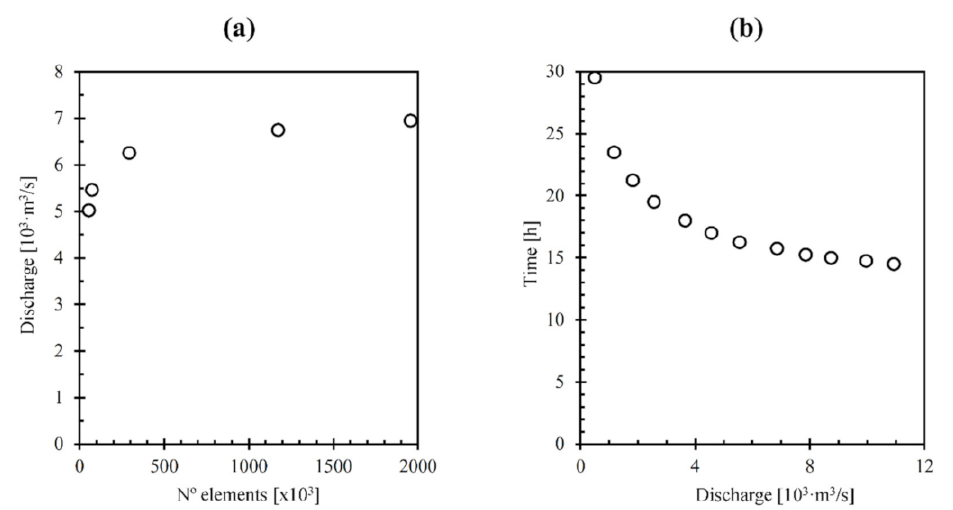
Figure 5. Sensitivity analysis in Case Study 2 (Marquelia basin): ( a ) variation of the peak discharge with the mesh size; ( b ) variation of the time of concentration with the rainfall